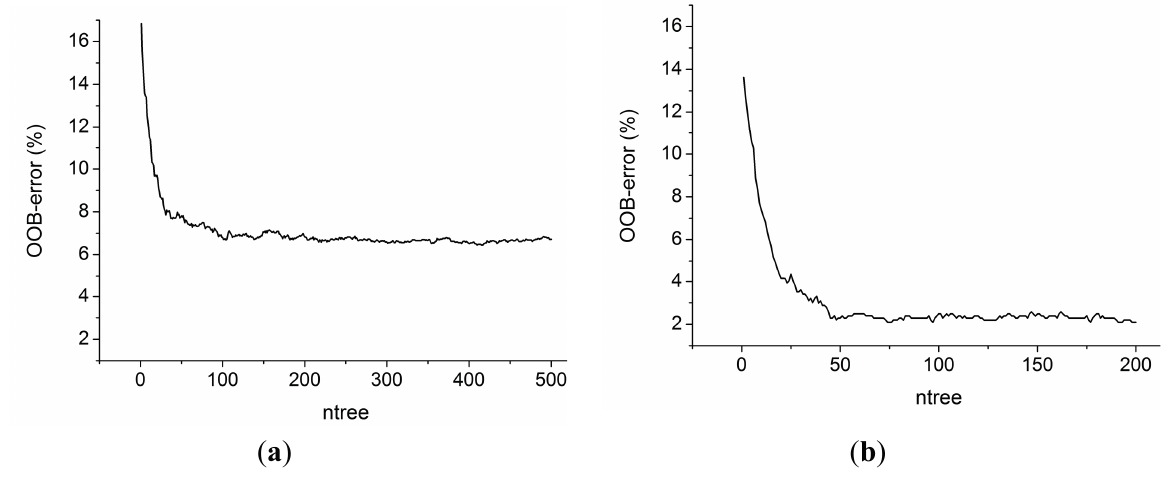
Figure 6. OOB error of Random Forest for Image-A uses a single window size for